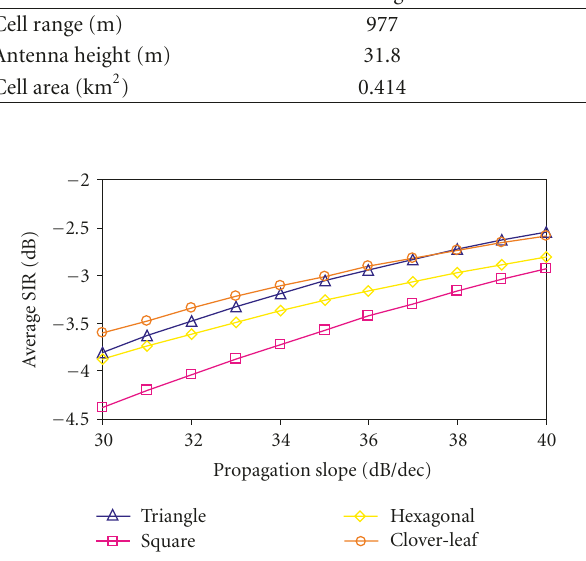
Figure 8: Maximum sector area as a function of antenna height for di ff erent